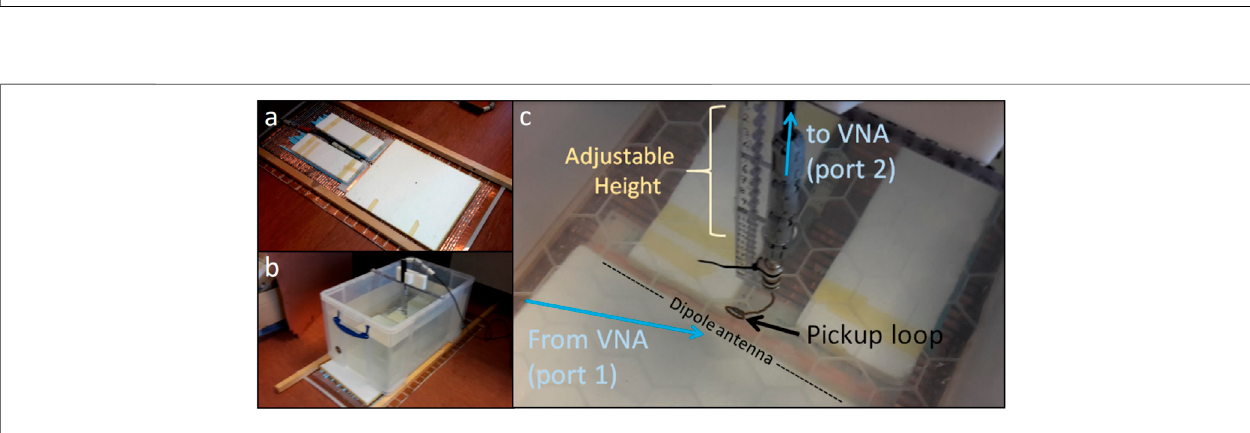
Frontiers in Physics |